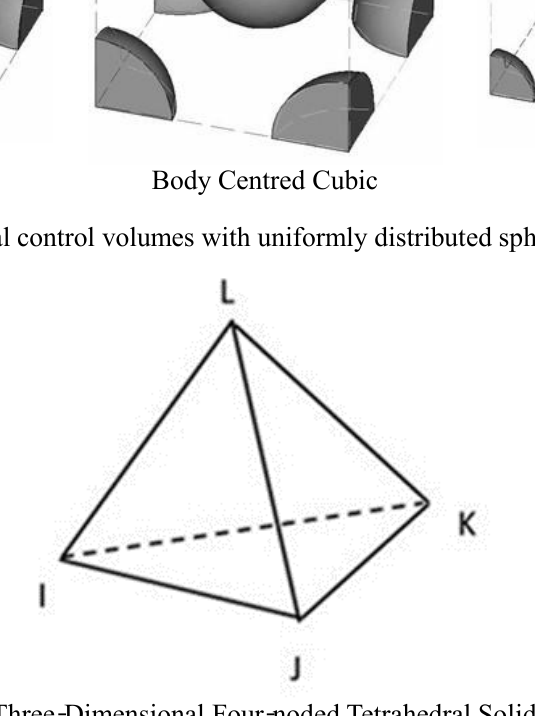
Fig. 4. A Three-Dimensional Four-noded Tetrahedral Solid